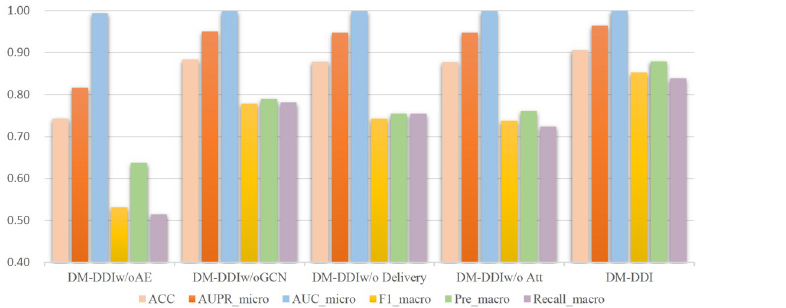
Fig 2. Comparison of the ablation experiment results.